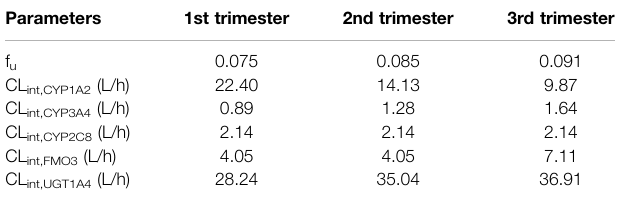
TABLE 2 | The setting of compound-related parameters in the pregnancy model. Parameters were adjusted based on their baseline values presuming 6-, 20-, and 34-weeks fertilization as representative of fi rst, second, and third trimesters, respectively.